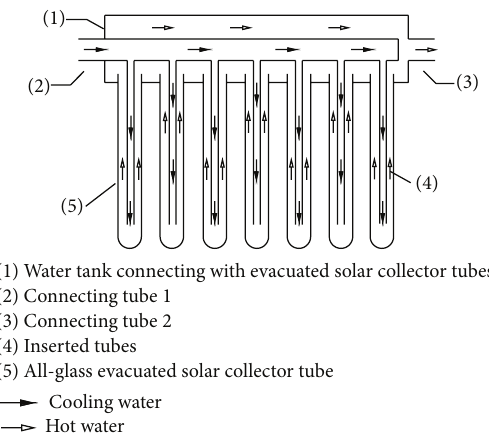
Figure 2: Water flow direction in all-glass evacuated tube collectors with a novel collector manifold header.